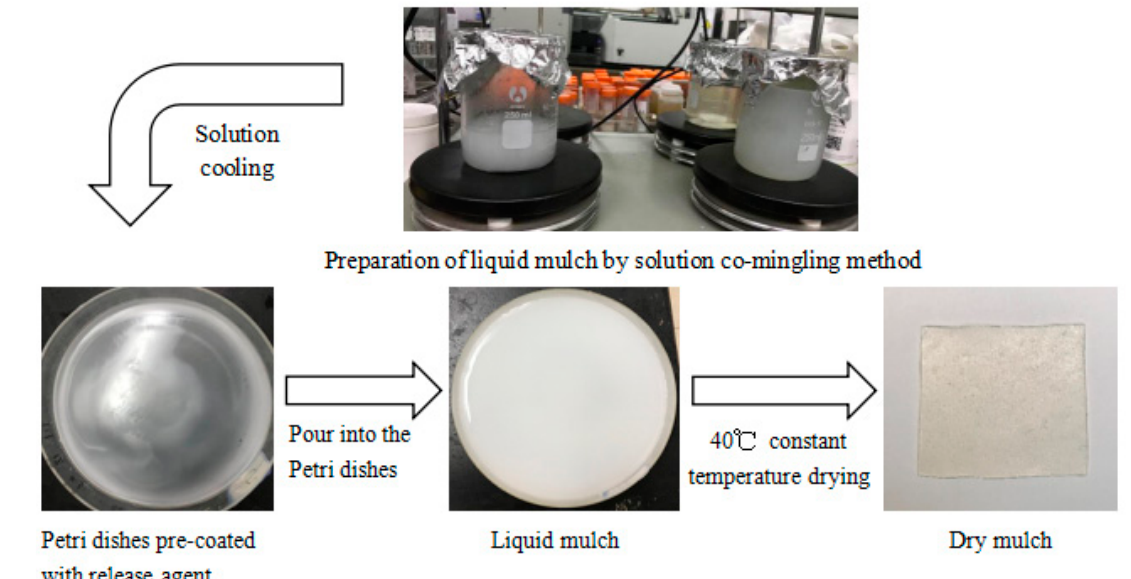
Figure 1. Modified corn starch and sodium alginate base film preparation